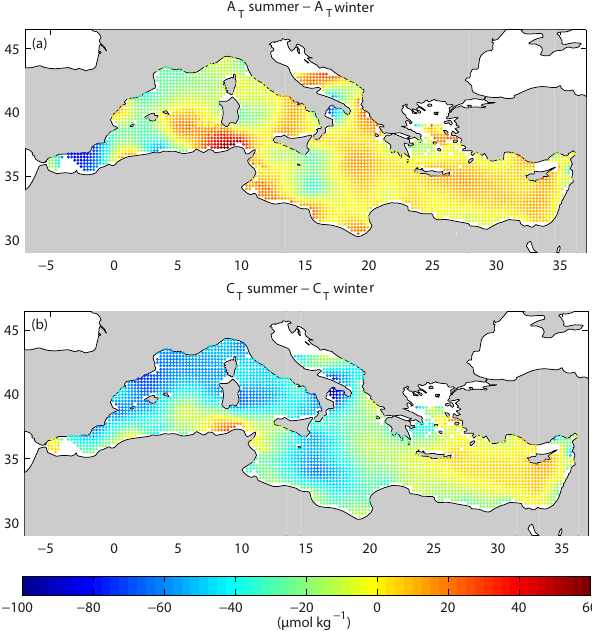
Figure 8. Distribution of the summer–winter differences of (a) sur- face A T predicted from Eq. (1) and (b) surface C T predicted from Eq. (2), applied to the 2005–2012 climatological fields of S and T from the